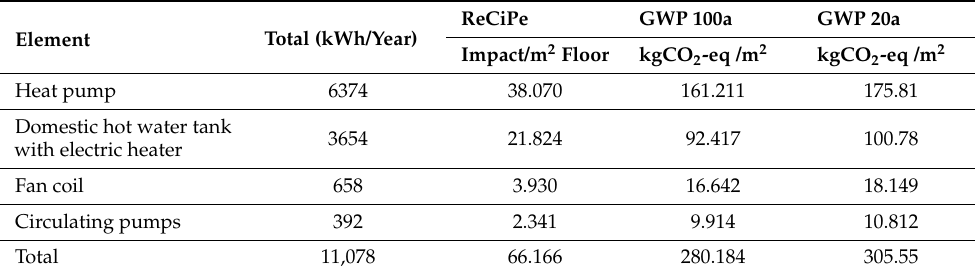
Table 10. LCIA of the innovative system during the operational stage for a 30-year